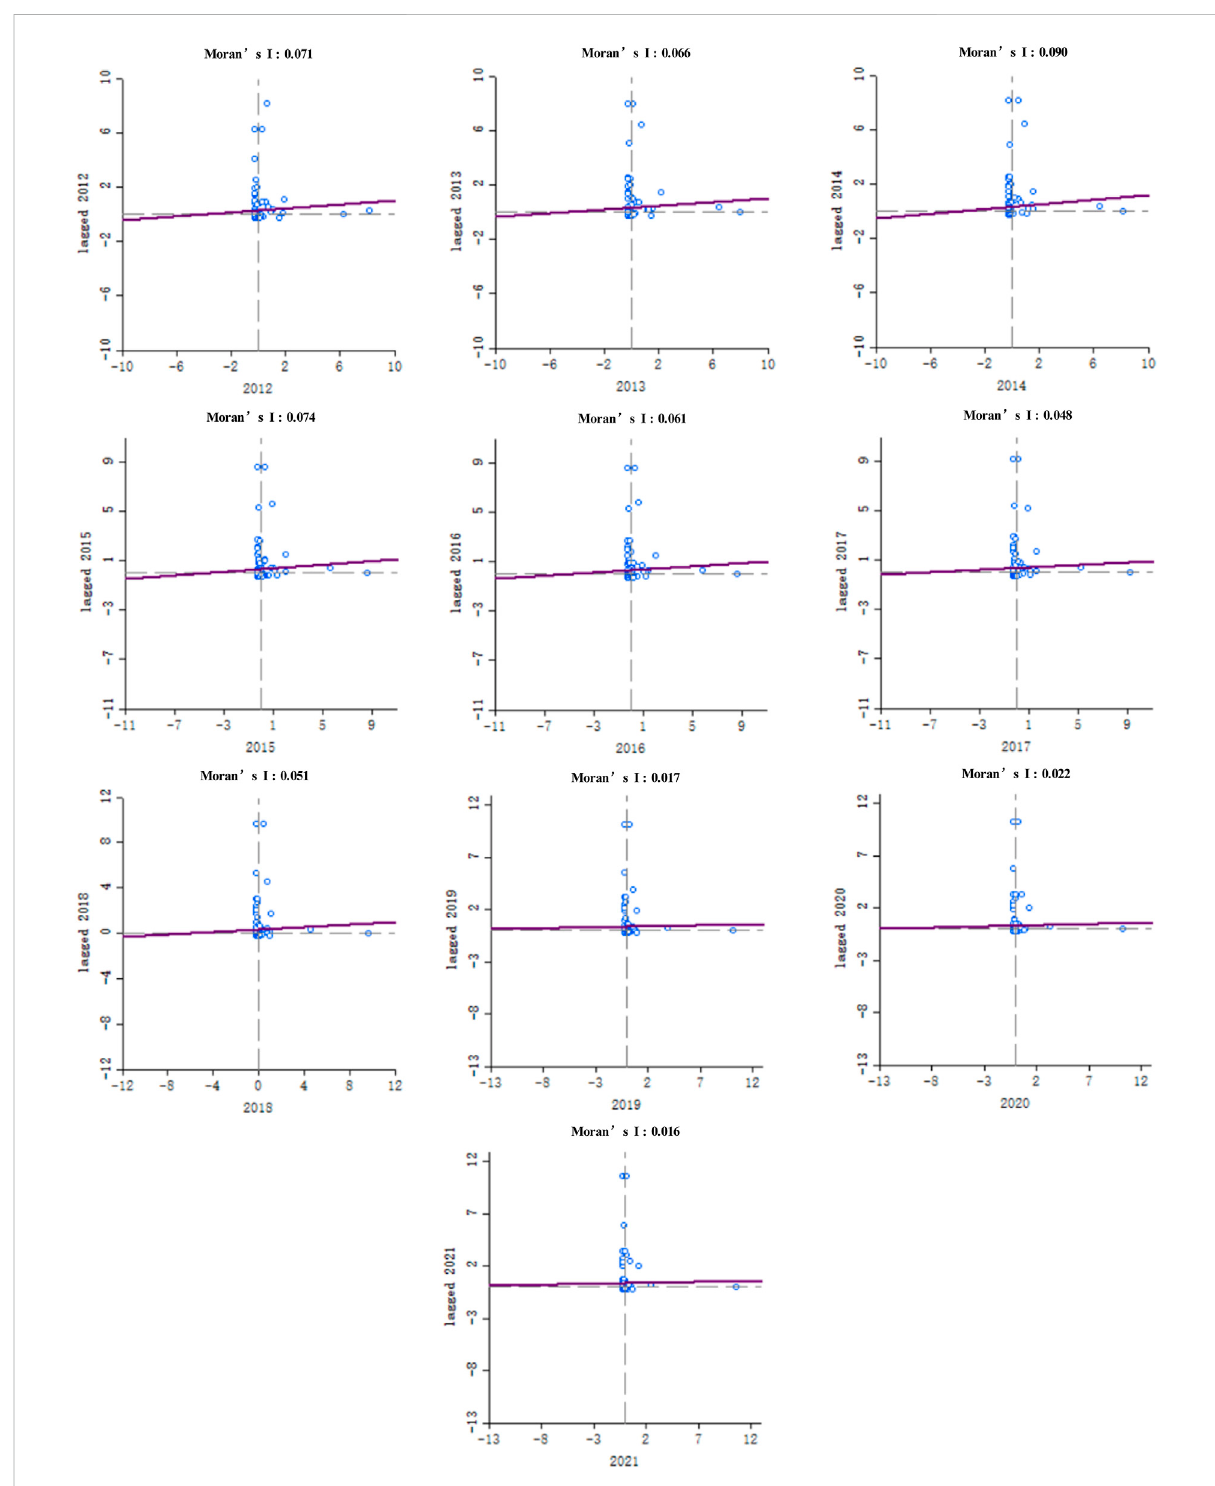
FIGURE 7 Scatterplot of the Moran index of the output of remote sensing